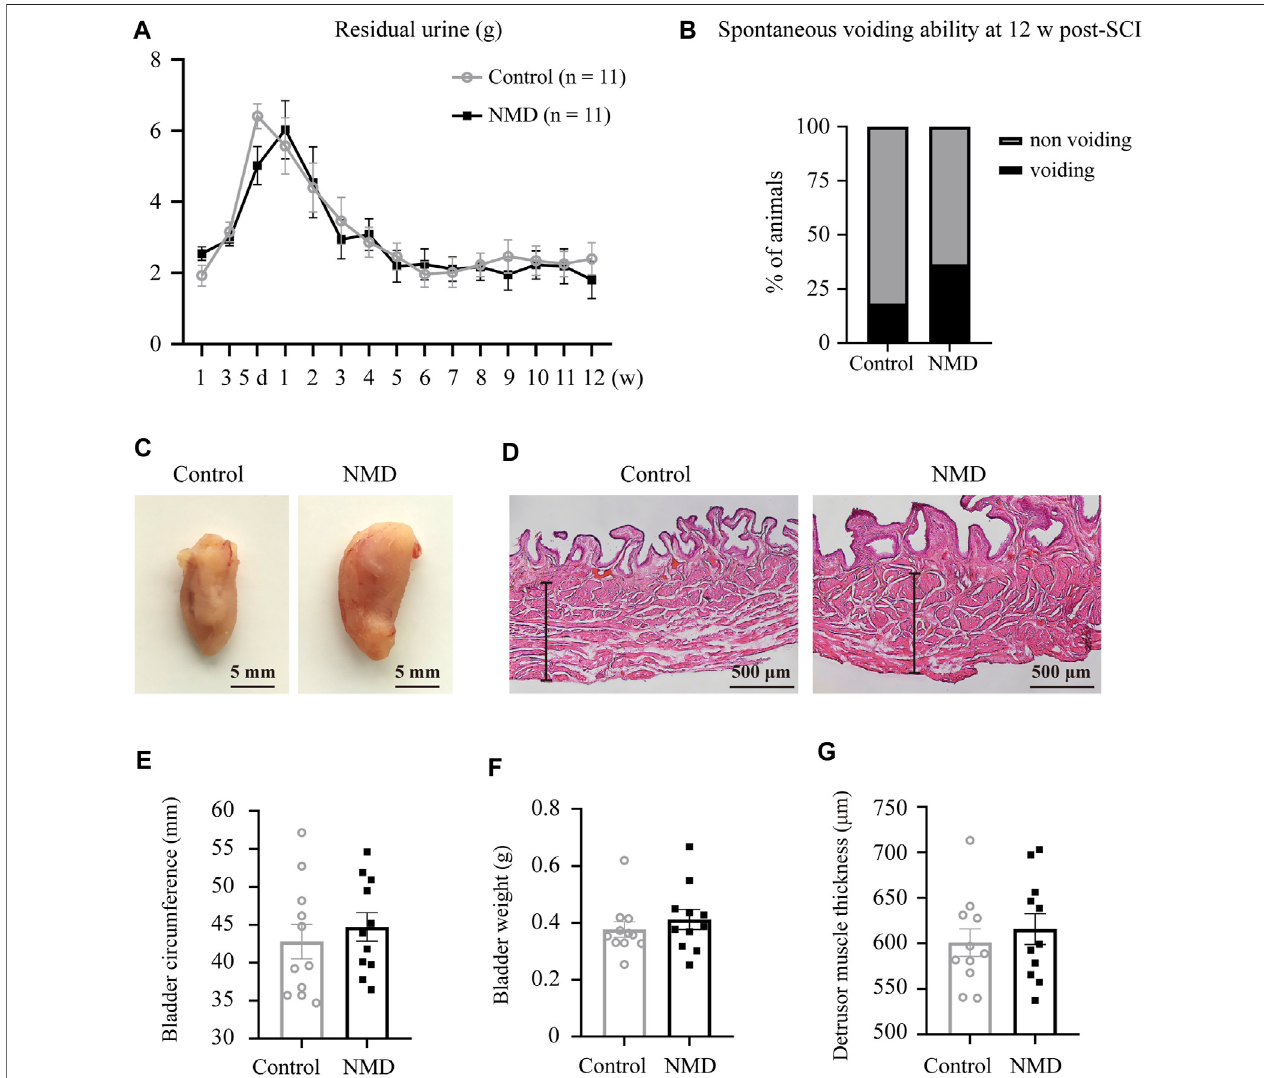
FIGURE8| Long-term administration ofNMD after SCI does notmitigaterat bladder dysfunction. (A) Plot ofthe residual urine weight over time ( n (cid:1) 11rats ineach group).Nosigni fi cantdifferences wereobservedbetweengroups usingtwo-way repeated-measuresANOVA[F(1,20) (cid:1) 0.1329, p > 0.05],but changesovertime were signi fi cant[F(6.045,120.9) (cid:1) 17.12, p < 0.0001]. (B) At12wpost-SCI,36.36%oftheNMDtreatedratsshowedspontaneousvoidingabilitycomparedto18.18%ofthe controls ( n (cid:1) 11 rats in each group). Two-tailed Fisher ’ s exact test, p > 0.05. (C) Representative images of bladders in control rats or NMD-treated rats. (D) RepresentativeimagesofHE-stainingofthebladderwallhistologyinthetwogroups.Theblacklinesdenotethethicknessofthedetrusormuscle. (E – G) Quanti fi cationof the bladder circumference, bladder weight, and thickness of the detrusor muscle in the two groups. Unpaired t-test, p > 0.05.